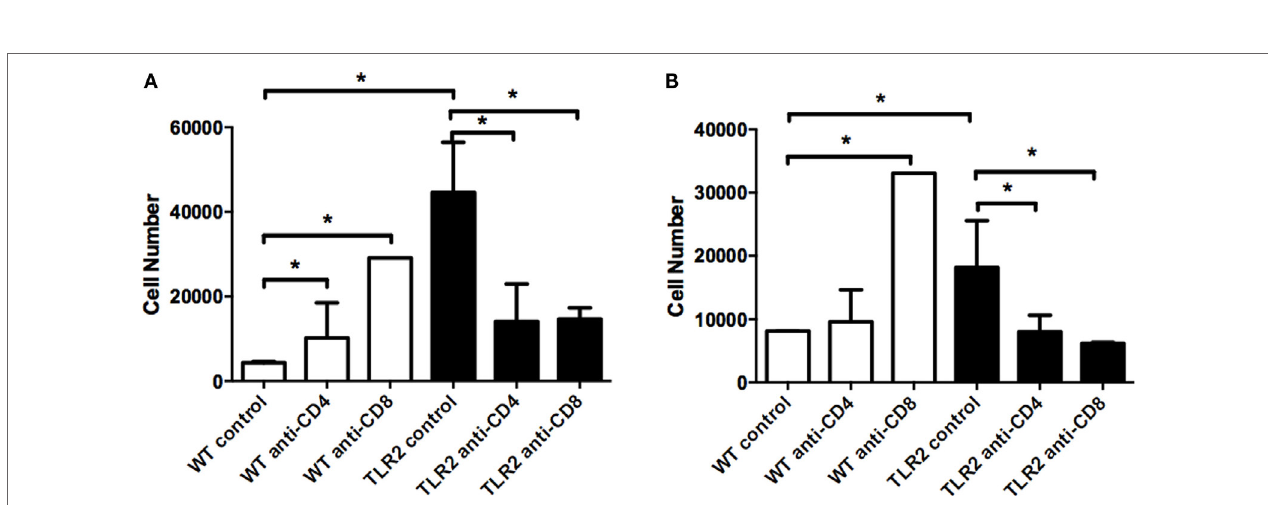
FigUre 7 | neutrophil and macrophage numbers in infected ankle joints . Mice were infected and treated as in Figure 4 . On day 21 postinfection, the mice were sacrificed and neutrophil (a) and macrophage (B) numbers were assessed from joint tissue. Data are representative of two separate experiments. n = 3, bars represent means ± SD. * p > 0.05.